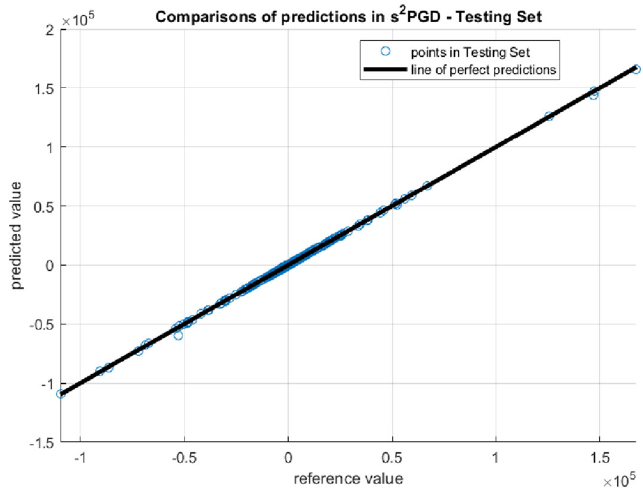
Fig. 12 Problem defined in Eq. 4.5: Comparison of predicted s 2 -PGD values with the reference ones in the testing set (the black line represents a perfect